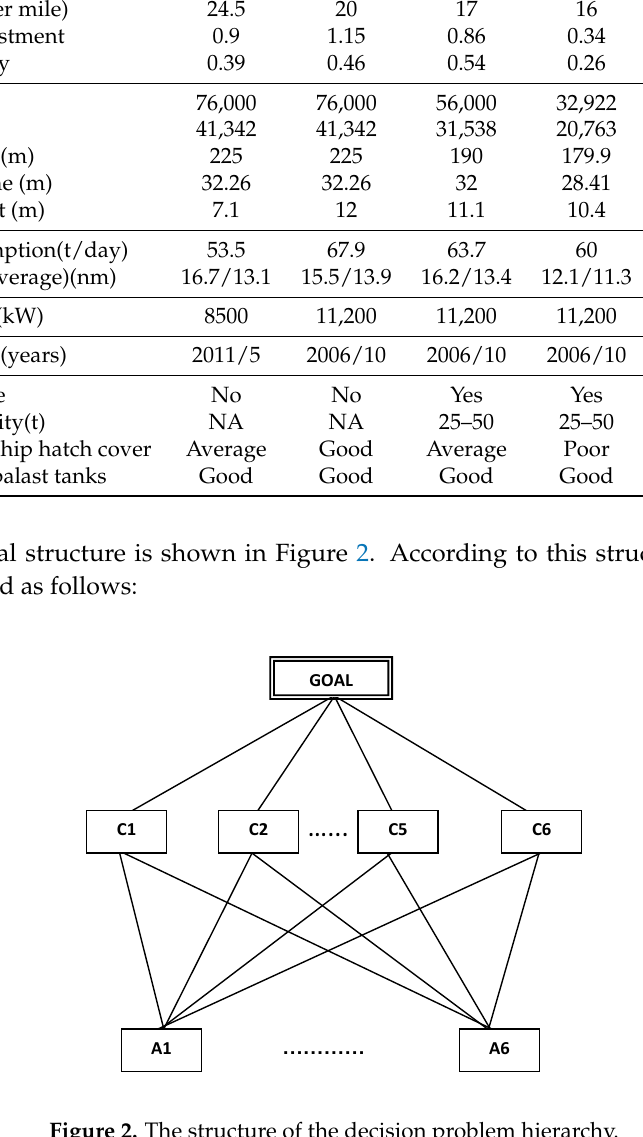
Figure 2. The structure of the decision problem hierarchy.